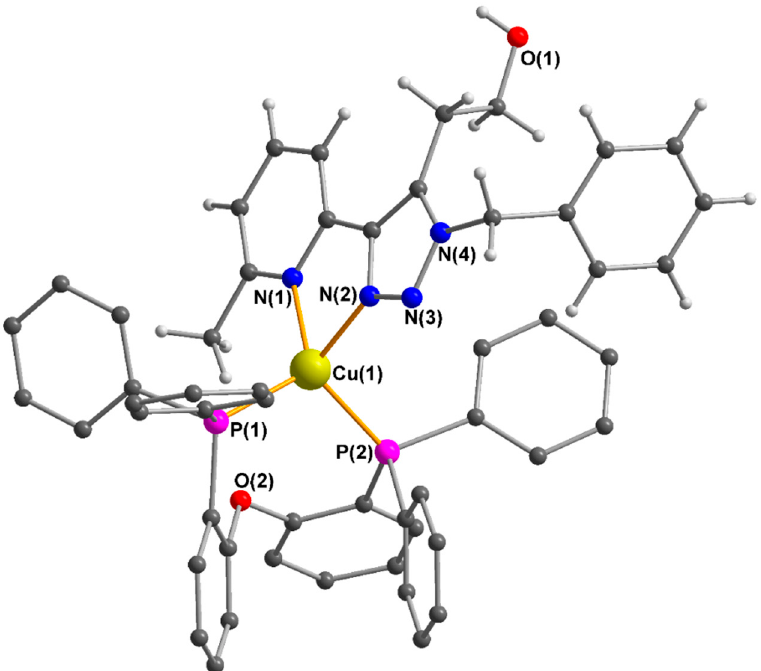
Figure 3. Molecular structure of the Cu(I) complex in 5b (counteranion, lattice solvent and hydro- gen atoms of the DPEPhos ligand omitted for clarity). Selected bond lengths (Å) and angle (°): Cu(1)-N(1) 2.112(3), Cu(1)-N(2) 2.048(4), Cu(1)-P(1) 2.2371(12), Cu(1)-P(2) 2.2459(12), N(1)-Cu(1)- N(2) 79.56(14).